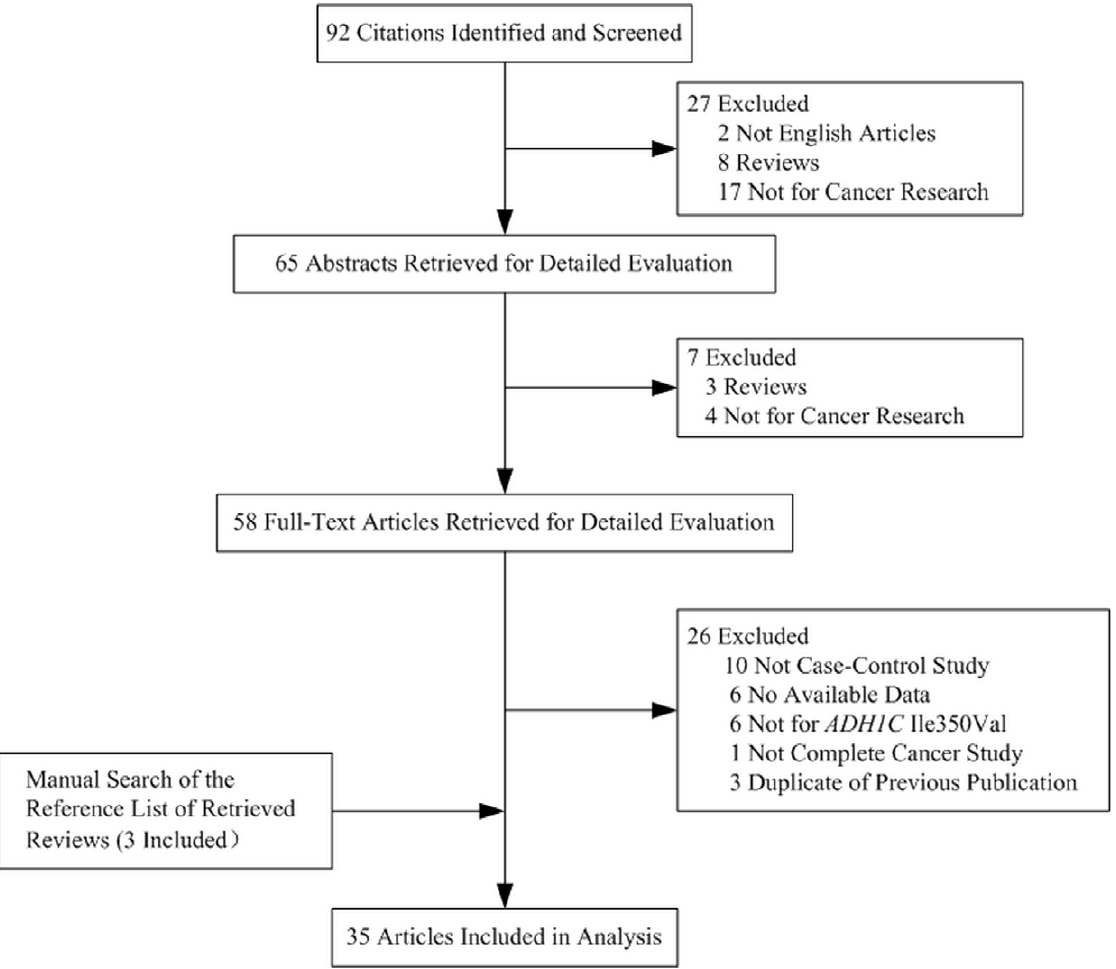
Figure 1. Studies identified with criteria for inclusion and exclusion.